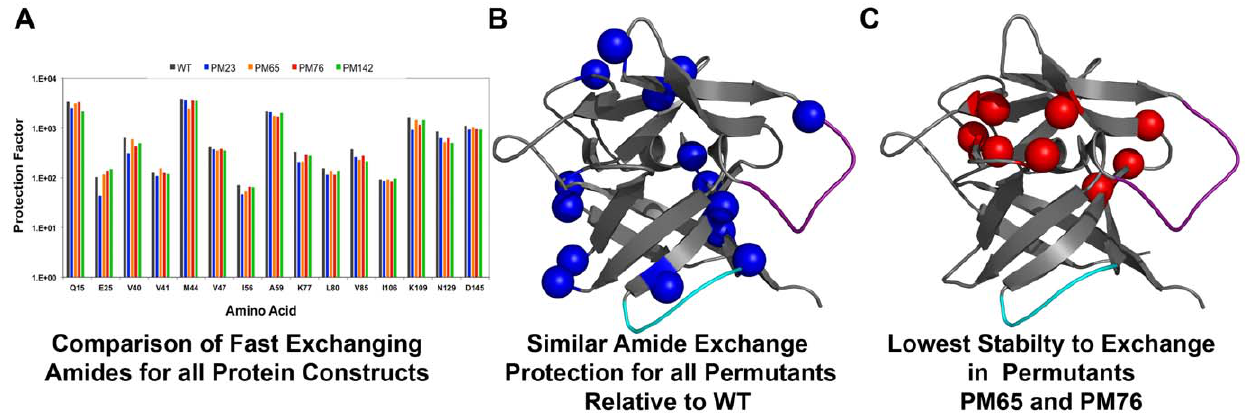
Figure 3. Summary of the native-state HDX indicates conservation of overall topology at the expense of individual backbone interactions. Molecular representations of the rates of HDX for the available backbone amide probes for all permutant variants compared to WT IL- 1 b . (A) Bar graph representing the calculated protection factors for the subset of backbone amides shown to exchange rapidly (fast exchanging) for WT and permutant variants of IL-1 b . (B) Blue spheres represent the fast-exchanging residues that maintain similar protection for all permutant variants. These residues are located throughout the surface regions of the molecule. (C) Differences between the individual permutant variants mapped by red spheres. PM65 and PM76 both showed greater loss of protection in a handful of residues, located mostly within the hairpin cap. In particular, destabilization of the residues involved in b -strand packing of the hairpin cap lead to the greatest loss in cooperativity seen in all the variants (Fig. 2B).